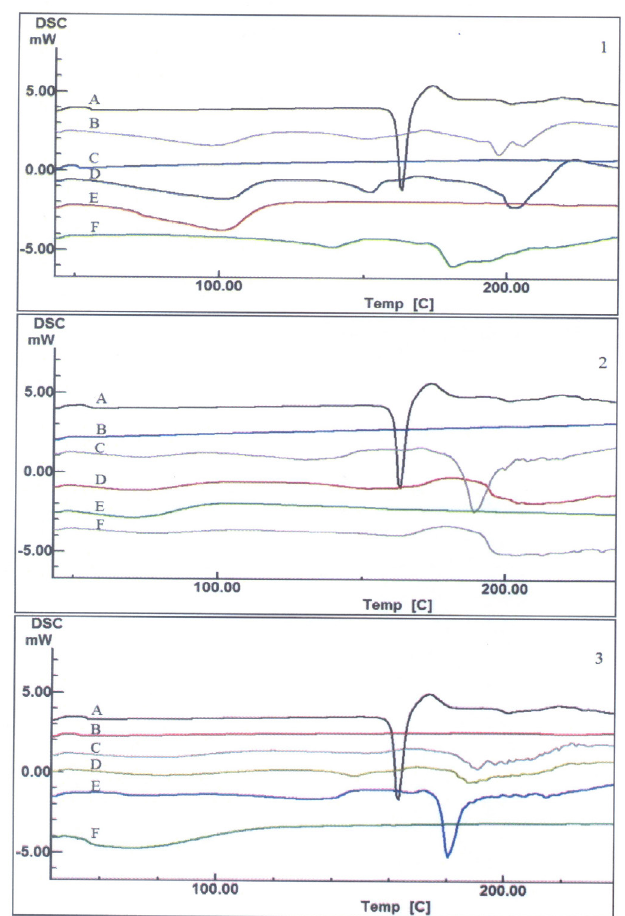
FIGURE 3 - DSC thermograms: 1: (A) AMH powder, (B) physical mixture, (C) spray-dried, (D) coevaporated, (E) β-CD and (F) freeze-dried; 2: (A) AMH powder, (B) spray-dried, (C) coevaporated, (D) physical mixture, (E) freeze-dried and (F) Methyl-β-CD; and 3: (A) AMH powder, (B) spray-dried, (C) coevaporated, (D) physical mixture, (E) freeze-dried and (F)